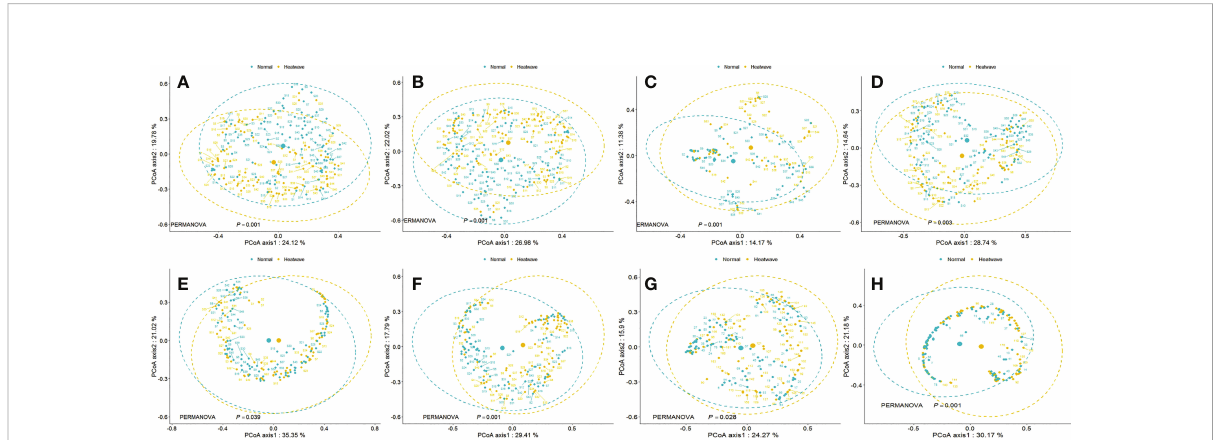
FIGURE 11 Principal coordinate analyses of Bray-Curtis distances on nekton community composition, calculated between NY (before MHWs) and MHWs for the (A) Overall community, (B) Fish community, (C) Cephalopod community, (D) Crustacean community, (E) WW community, (F) WT community, (G) FG1 community, and (H) FG2 community. Each dot represents a site.